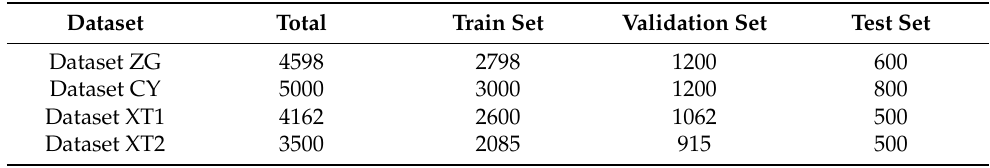
Table 2. The four datasets for domain